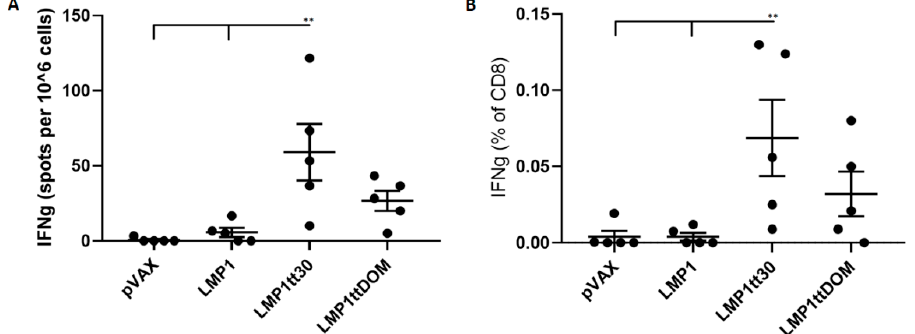
Figure A2. Engineered LMP1 vaccines enhance cellular immunity. The LMP1 antigen was truncated at the N-terminal, received an IgE leader sequence, and had tetanus toxoid added to its sequence. Splenocytes were stimulated with the 5 strongest MHC class I peptides to LMP1, as predicted in silico, after C57BL/6 mice were vaccinated. ( A ) IFN γ ELISPOT results showing an average of 59 sfu for LMP1tt30. ( B ) Flow cytometry data showing improved CD8 responses following plasmid engineering.